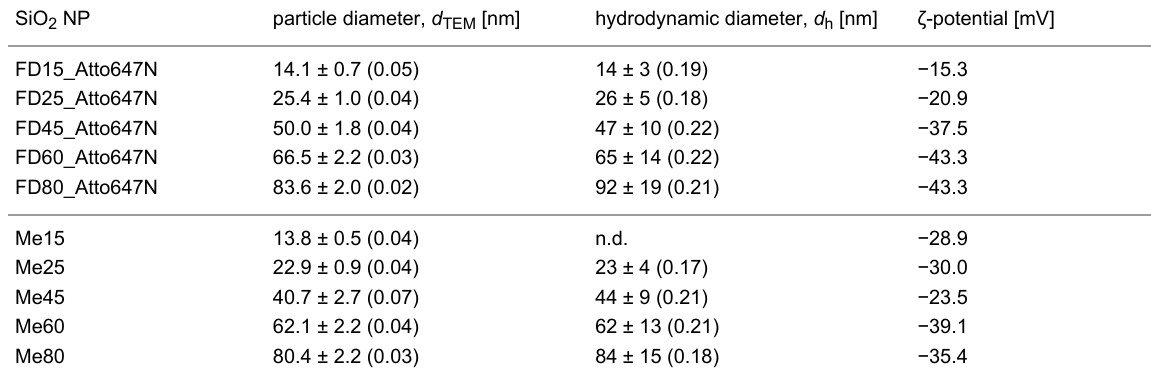
Table 1: Overview of the physical particle attributes (size, degree of dispersion, and charge) of the synthesised Atto647N-dyed silica nanoparticles. To determine the particle diameter and the size distribution, the samples were characterised by TEM image analysis. The hydrodynamic diameter of the particles in H 2 O was measured by DLS, whereas the particle charge was determined by ζ -potential measurements. The mean hydrodynamic diameter of the particles was determined, using the “volume distribution”. Numbers in brackets indicate the size dispersity p . It is calculated with the formula p = σ / μ with σ being the standard deviation and μ being the mean value. n.d. = not